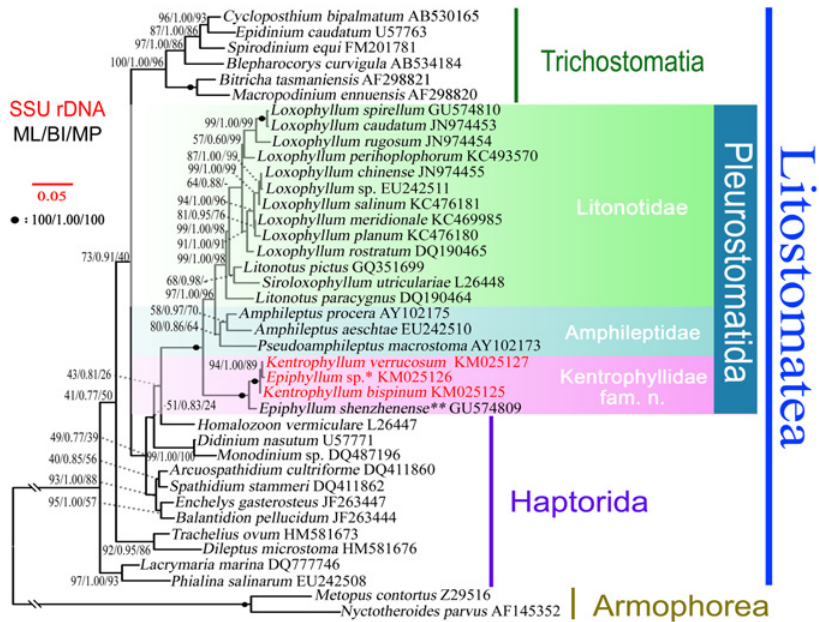
Fig 1. Phylogenetic tree constructed from 39 SSU rDNA sequences of litostomatean ciliates. Numbers at nodes indicate bootstrap values for maximum likelihood (ML), posterior probabilities from Bayesian analysis (BI) and bootstrap values from maximum parsimony (MP), respectively. GenBank accession numbers are given after names of species. Newly sequenced species are marked with a red. Scale bar corresponds to five substitutions per 100 nucleotide positions. * Designated as Kentrophyllum strumosum sp. n. in present work. ** Designated as Kentrophyllum shenzhenense (Pan et al., 2010) comb. n. in present